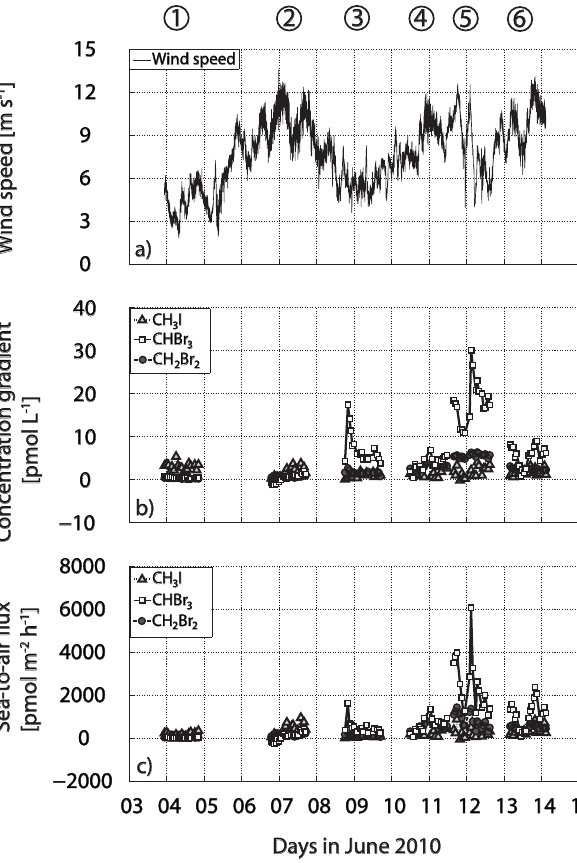
Fig. 5. Wind speed (a) , concentration gradients (b) and sea-to-air fluxes (c) of CH 3 I, CHBr 3 and CH 2 Br 2 during